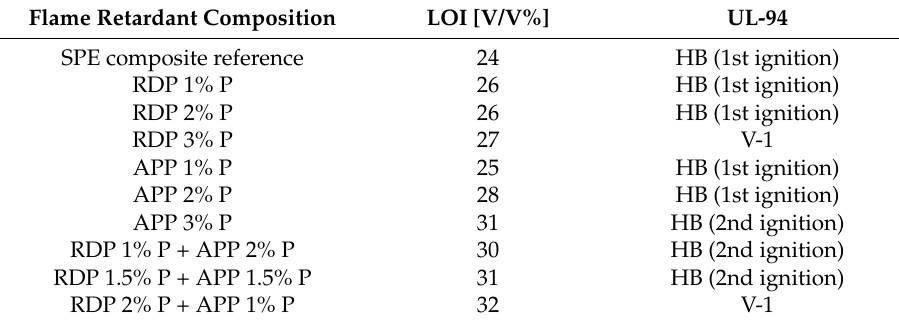
Table 1. Limiting oxygen index (LOI) and UL-94 results of the flame retarded sorbitol polyglycidyl ether (SPE) composites. Flame Retardant Composition LOI [V/V%]